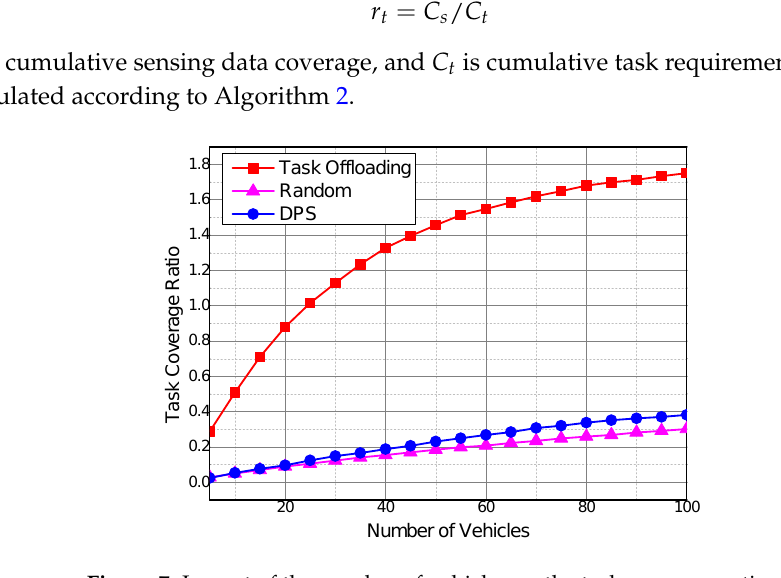
Figure 7. Impact of the number of vehicles on the task coverage